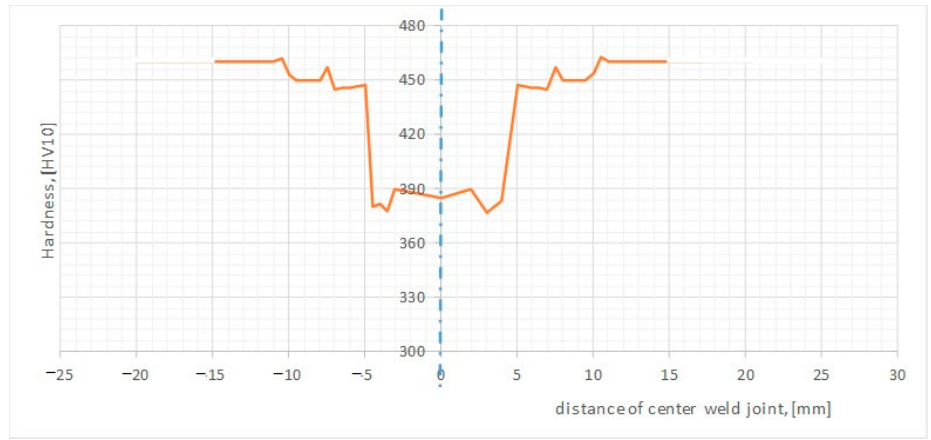
Figure 5. Hardness changes in the welded joint of Hardox 450 steel for specimen Sa1.